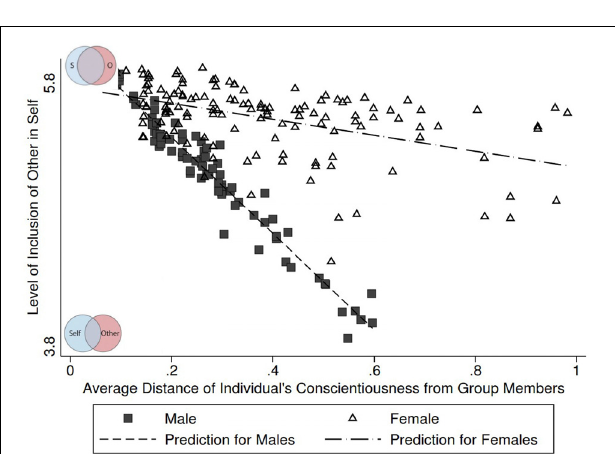
FIGURE 4 | Associations of variation in group conscientiousness and group bonding in male and female friendship groups. Personality measured as individual distance to other group members for male and female groups taking into account heteroscedasticity. Group bonding measured through the Inclusion of Other in